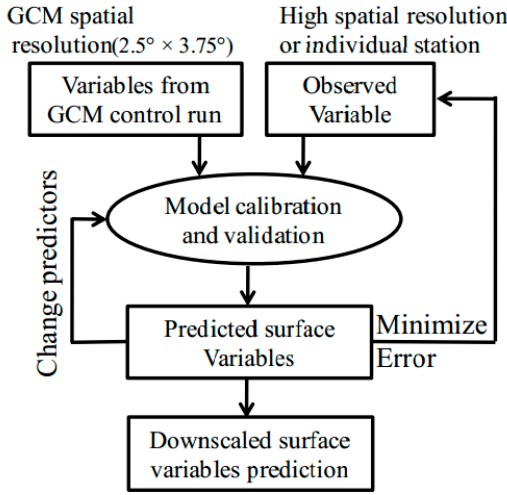
Figure 2. Diagram of downscaling procedure in statistical downscaling model (SDSM) [38].